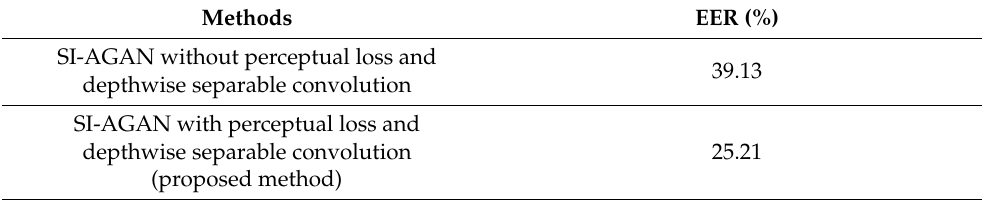
Table 14. Comparisons of gender recognition accuracies using the reconstructed visible-light